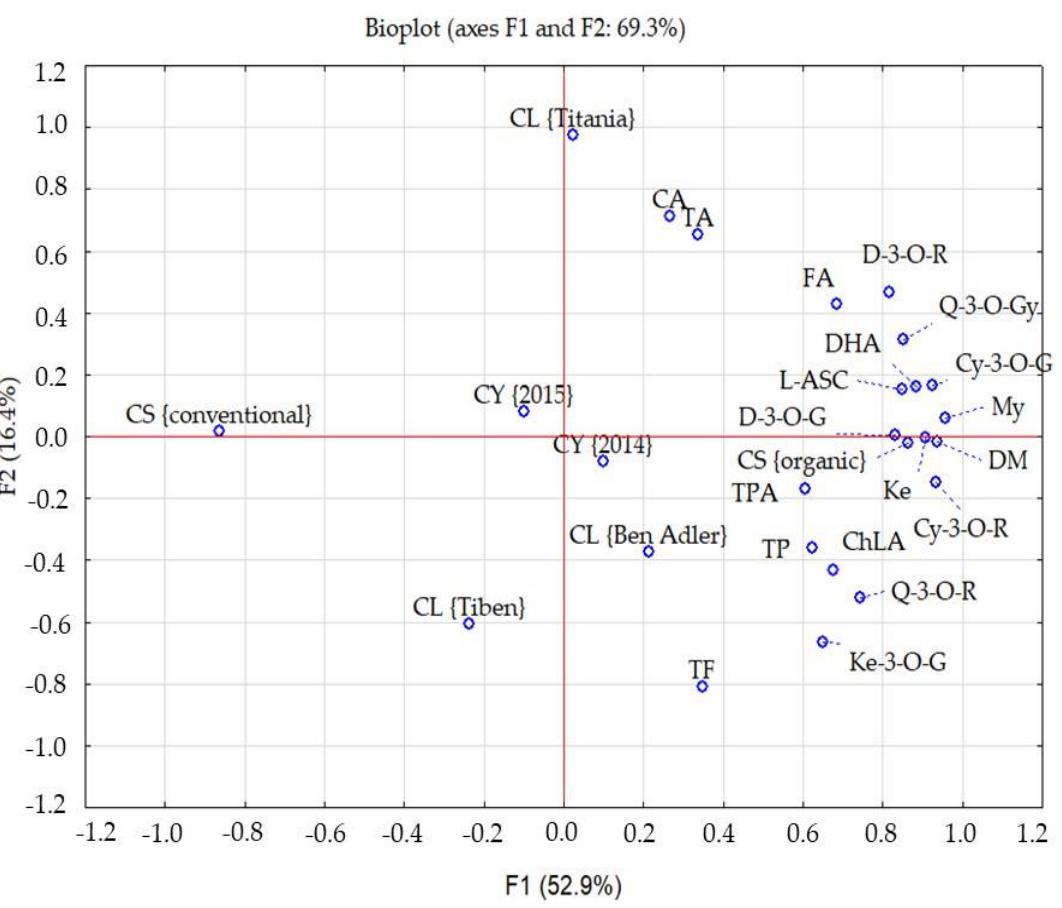
Figure 4. PCA analysis showing the relationship between the chemical composition—total polyphenols (TP), total phenolic acids (TPA), chlorogenic acid (ChLA), caffeic acid (CA), quercetin-3-O-glycoside (Q-3-O-Gy), ferulic acid (FA), total flavonoids (TF), kaempferol-3-O-glycoside (Ke-3-O-G), quercetin-3-O-rutinoside (Q-3-O-R), myricetin (My), kaempferol (Ke), total anthocyanins (TA), quercetin-3-O-glucoside (Q-3-O-G), cyanidin-3-O-rutinoside (Cy-3-O-R), delphinidin-3-O-rutinoside (D-3-O-R), cyanidin-3-O-glycoside (Cy-3-O-G) and delphinidin-3-O-glucoside (D-3-O-G), in to experimental cultivation year (CY), cultivar (CL) and agronomic system (AS).